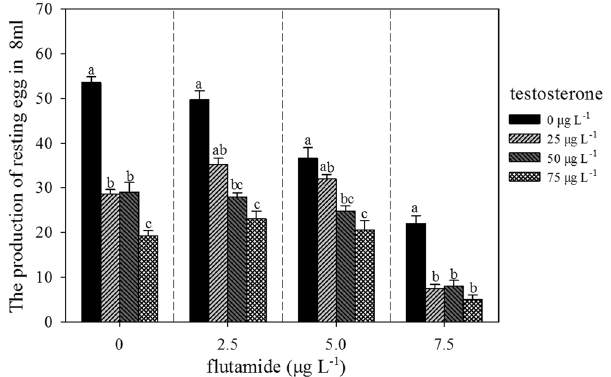
Figure 4. Effects of testosterone and flutamide on the number of resting eggs produced at 7 d in B. calyciflorus (n =